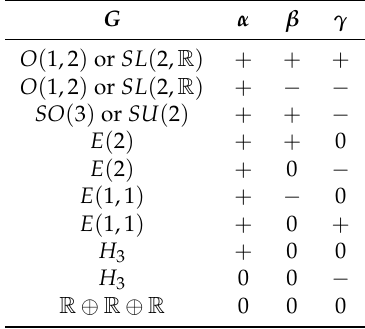
Table 2. Lie groups G with Lie algebra of type g 3